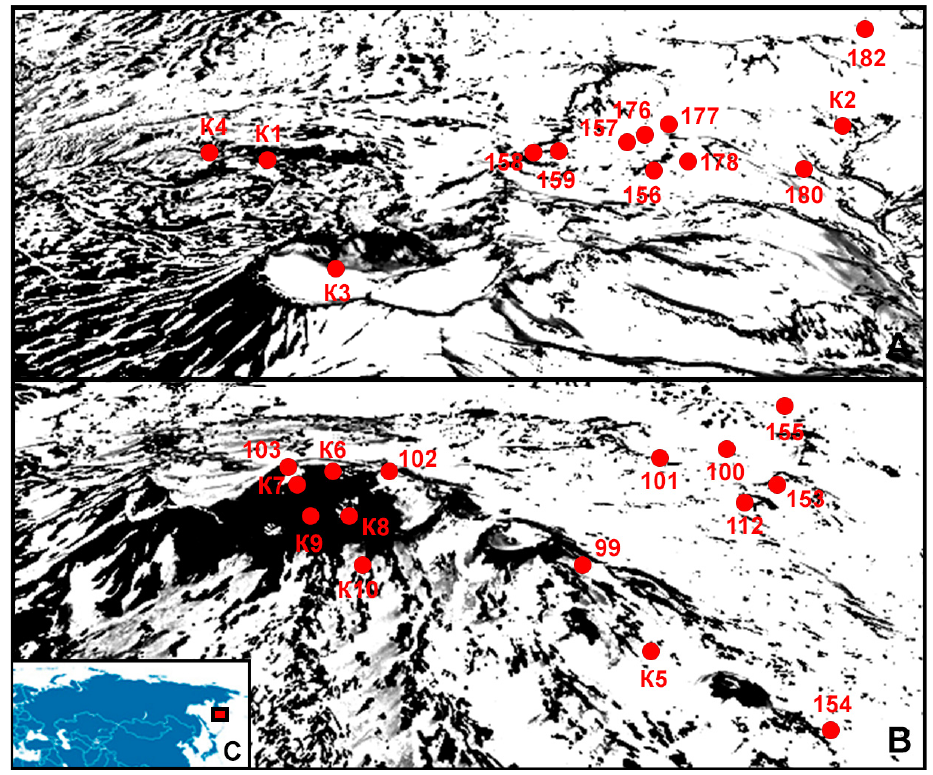
Figure 1. Study area. ( A ) Mutnovsky volcano. The red dots indicate the sampling sites. ( B ) Gorely volcano. ( C ) The red rectangle indicates the Kamchatka Peninsula. (According to [33], with modifications.)